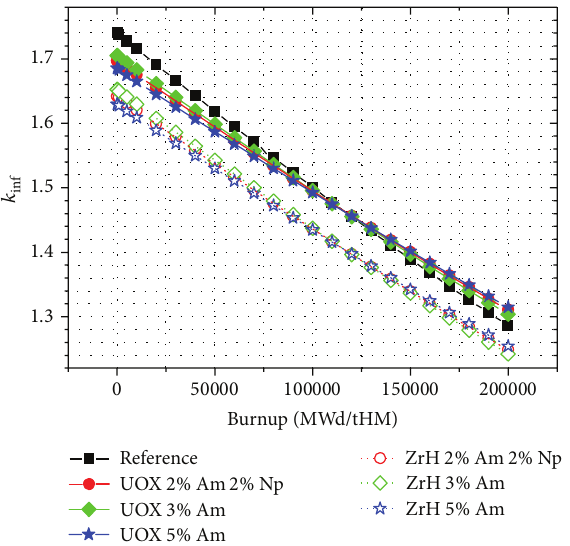
Figure 5: Change in the infinite multiplication factor over the burnup for the three different material configurations.